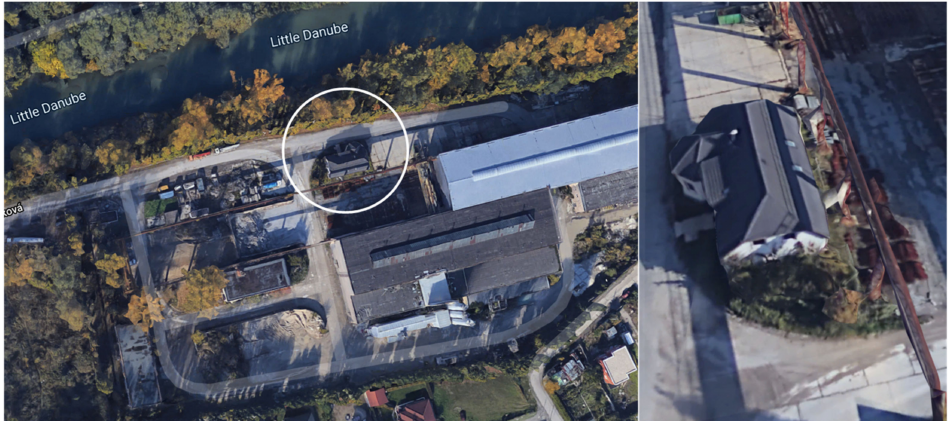
Figure 20. Location of the prototype of the prefabricated house IDA I. within Bratislava, Slovak Republic. (https://www.google.com/maps, accessed on 17 August 2022).